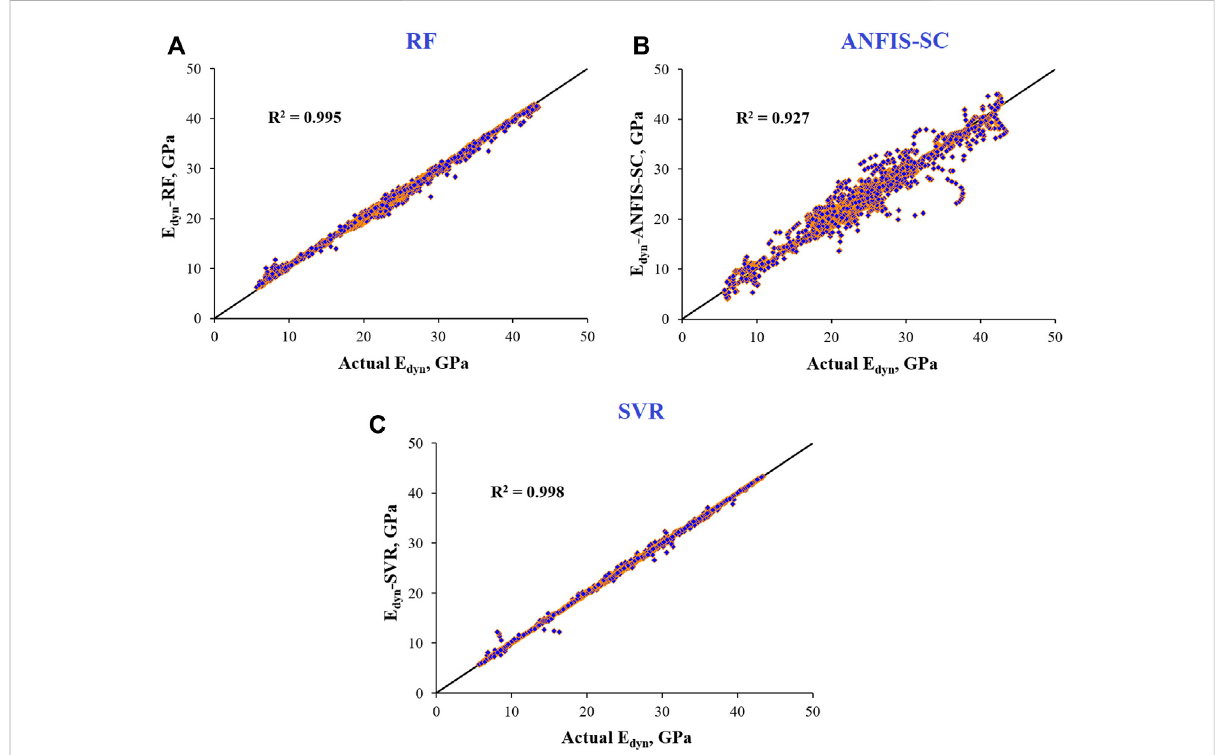
FIGURE 4 Actual and assessed E dyn by the (A) RF, (B) ANFIS-SC, and (C) SVR models for the 2054 training data points of